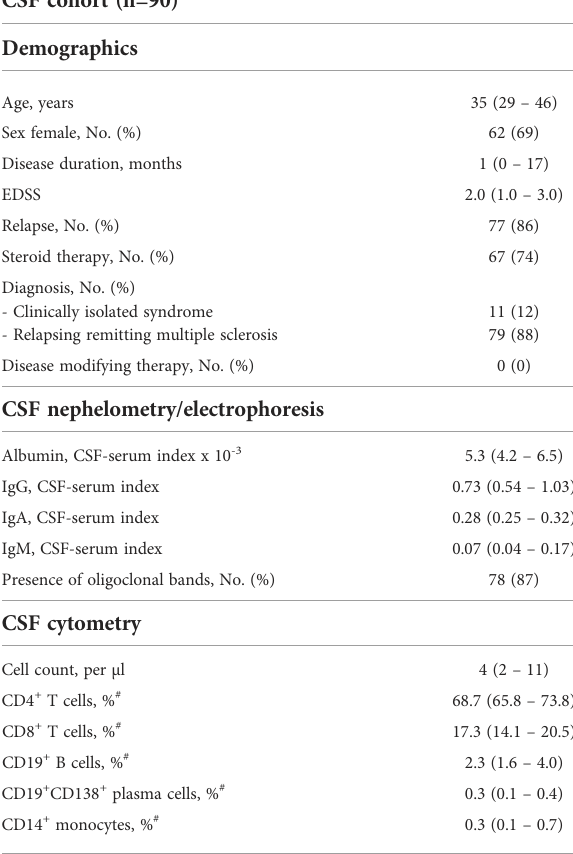
TABLE 1 Clinical and CSF characteristics of the CSF cohort.